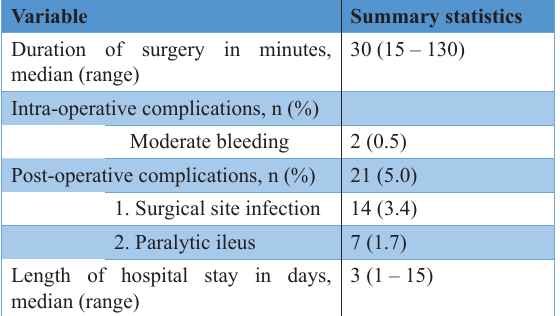
Table 2. Intra-operative and post-operative characteristics of